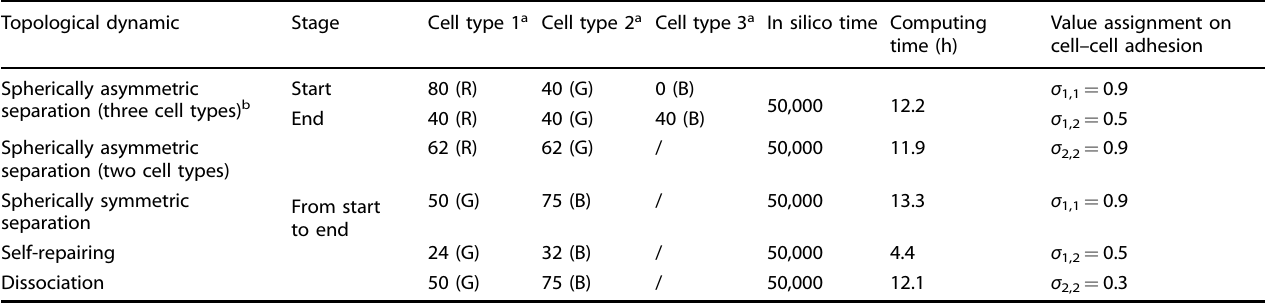
Table 2. Parameter settings and time scales of the synNotch